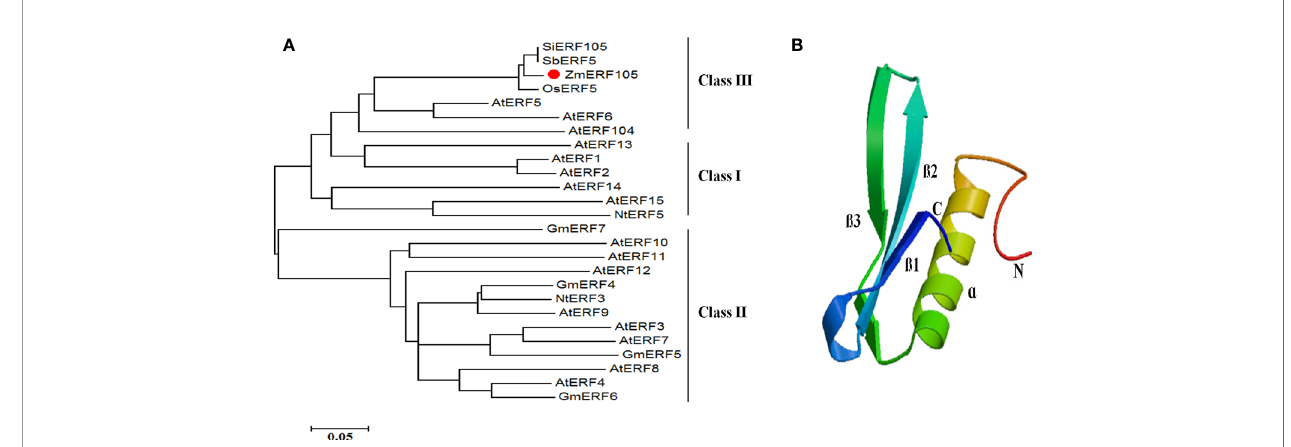
FIGURE 2 | The phylogenetic tree and predicted three-dimensional structure of ZmERF105 protein. (A) The phylogenetic tree was generated with the neighbor- joining method using MEGA 5.0 software. ZmERF105 is indicated by the red dot. The accession numbers are as follows: AtERF1 (NP188965), AtERF2 (NP199533), AtERF3 (NP175479), AtERF4 (NP188139), AtERF5 (NP568679), AtERF6 (NP567529), AtERF7 (NP188666), AtERF8 (NP175725), AtERF9 (NP199234), AtERF10 (NP171876), AtERF11 (NP174159), AtERF12 (NP174158), AtERF13 (NP182011), AtERF14 (NP171932), AtERF15 (NP9850162), AtERF104 (NP_200968), GmERF4 (ACE76905), GmERF5 (AEX25891), GmERF6 (AEQ55267), GmERF7 (AEQ55266), NtERF3 (BAJ72664), NtERF5 (AAU81956), SbERF5 (XP021315889), SiERF105 (XP004953326), and OsERF5 (XP015624058). (B) Predicted three-dimensional structure of ZmERF105